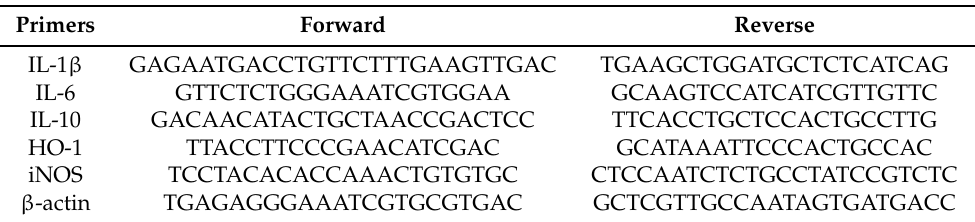
Table 1. Primer sequences used in quantitative real-time